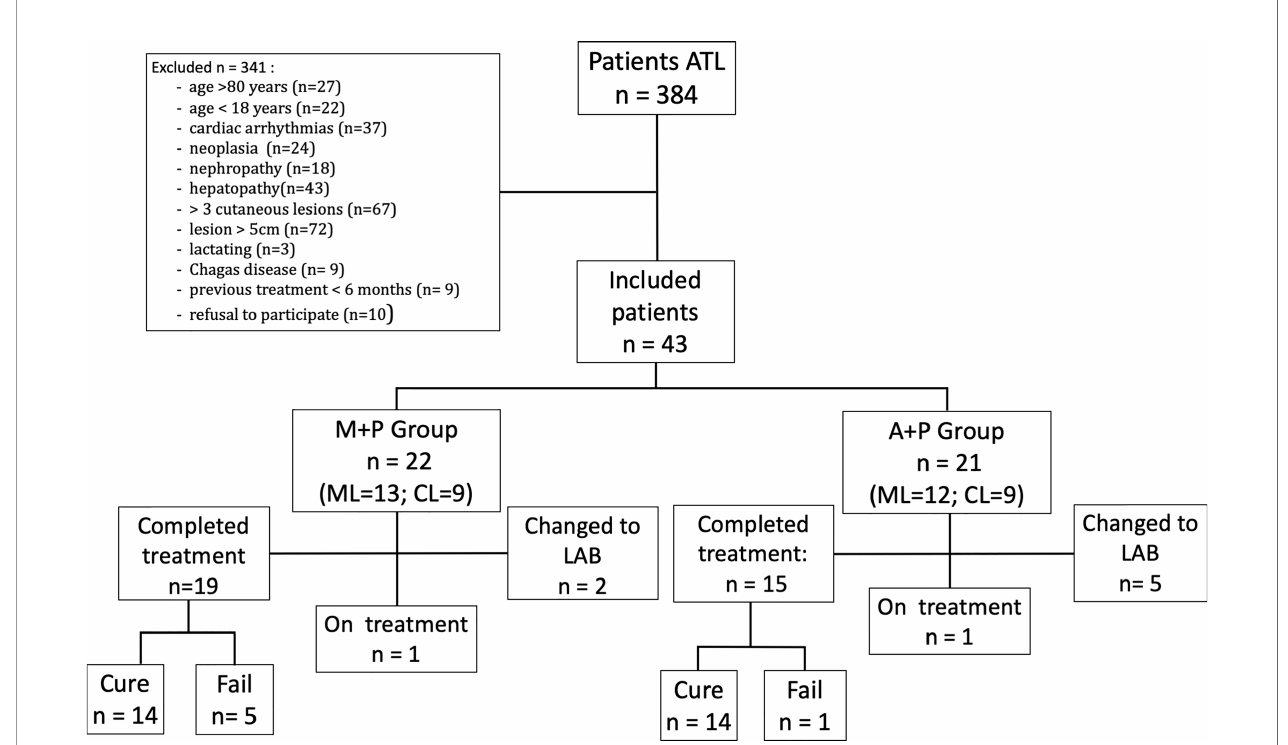
FIGURE 1 | Flow diagram showing eligible patients, randomized patients and cure